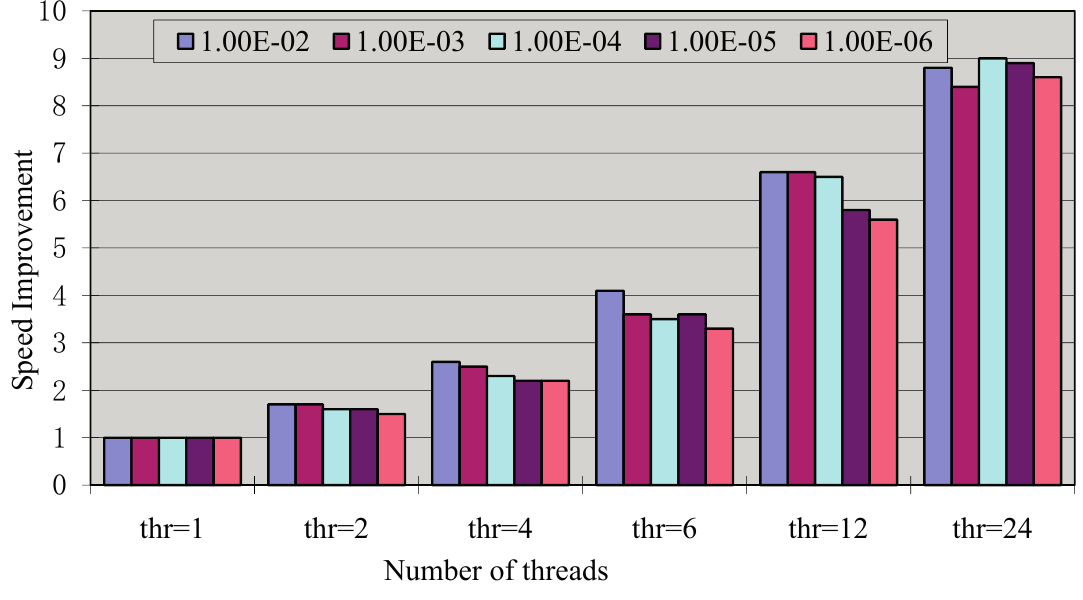
Figure 9. Speedup of SDDG-BUFFER with different computing threads and buffer widths.